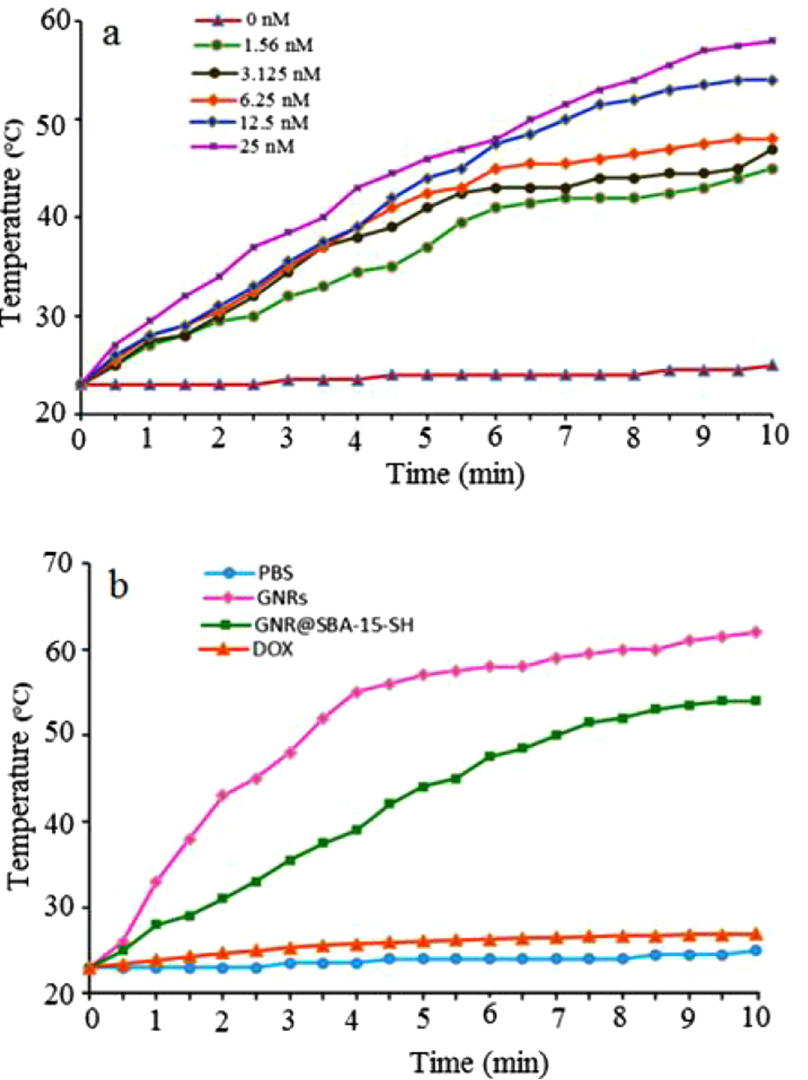
Figure 10: (a) Temperature elevation of the solutions containing different concentration GNRs@SBA-15-SH (0,